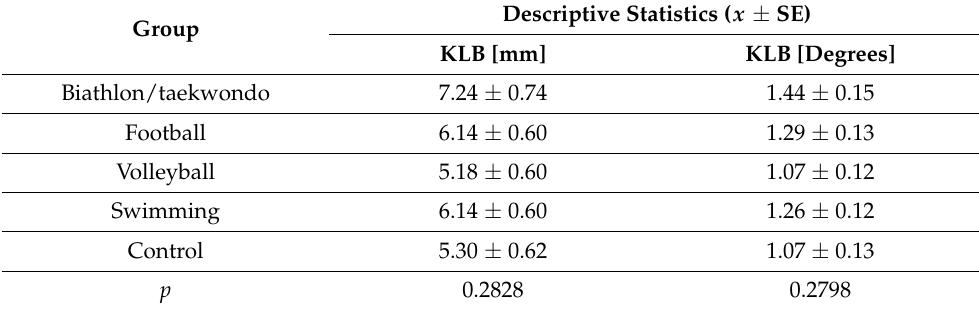
Table 3. Characteristics of the KLB parameter.